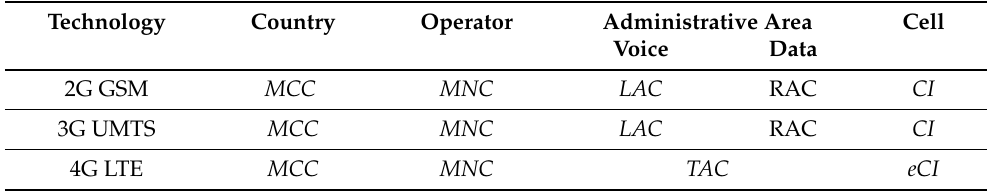
Table A1. Administrative view of cell identifiers.